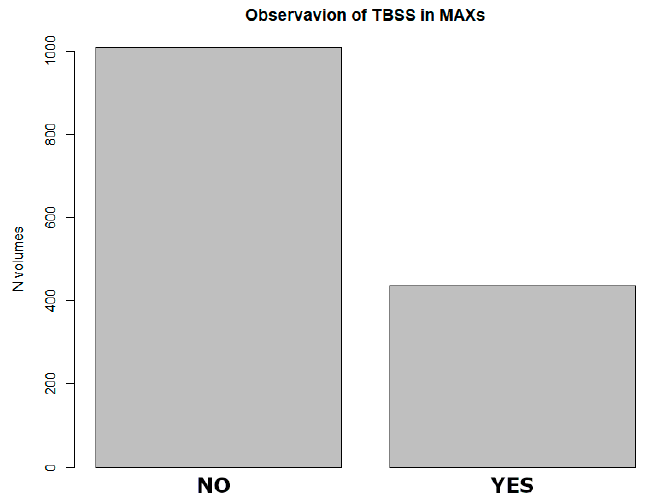
Figure 10. Proportion of MAXs without and with a TBSS signature .